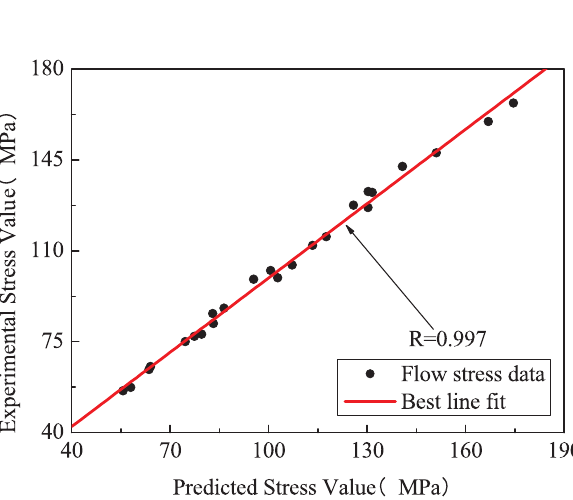
Fig. 9: The correlation between the experimental and predicted flow stress data from the developed constitutive equation over the experimental range of strain, strain rate and